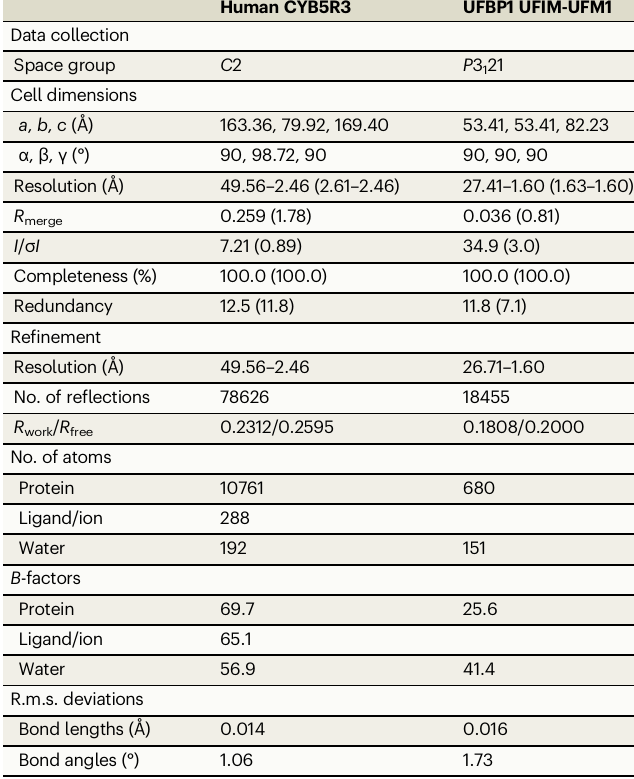
Table 1 | Data collection and re fi nement